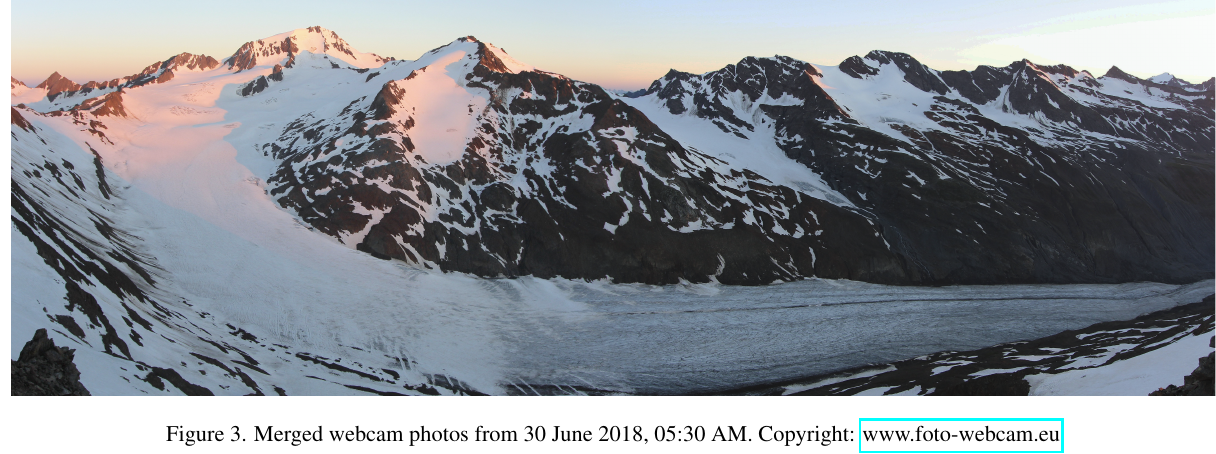
Figure 3. Merged webcam photos from 30 June 2018, 05:30 AM. Copyright: www.foto-webcam.eu